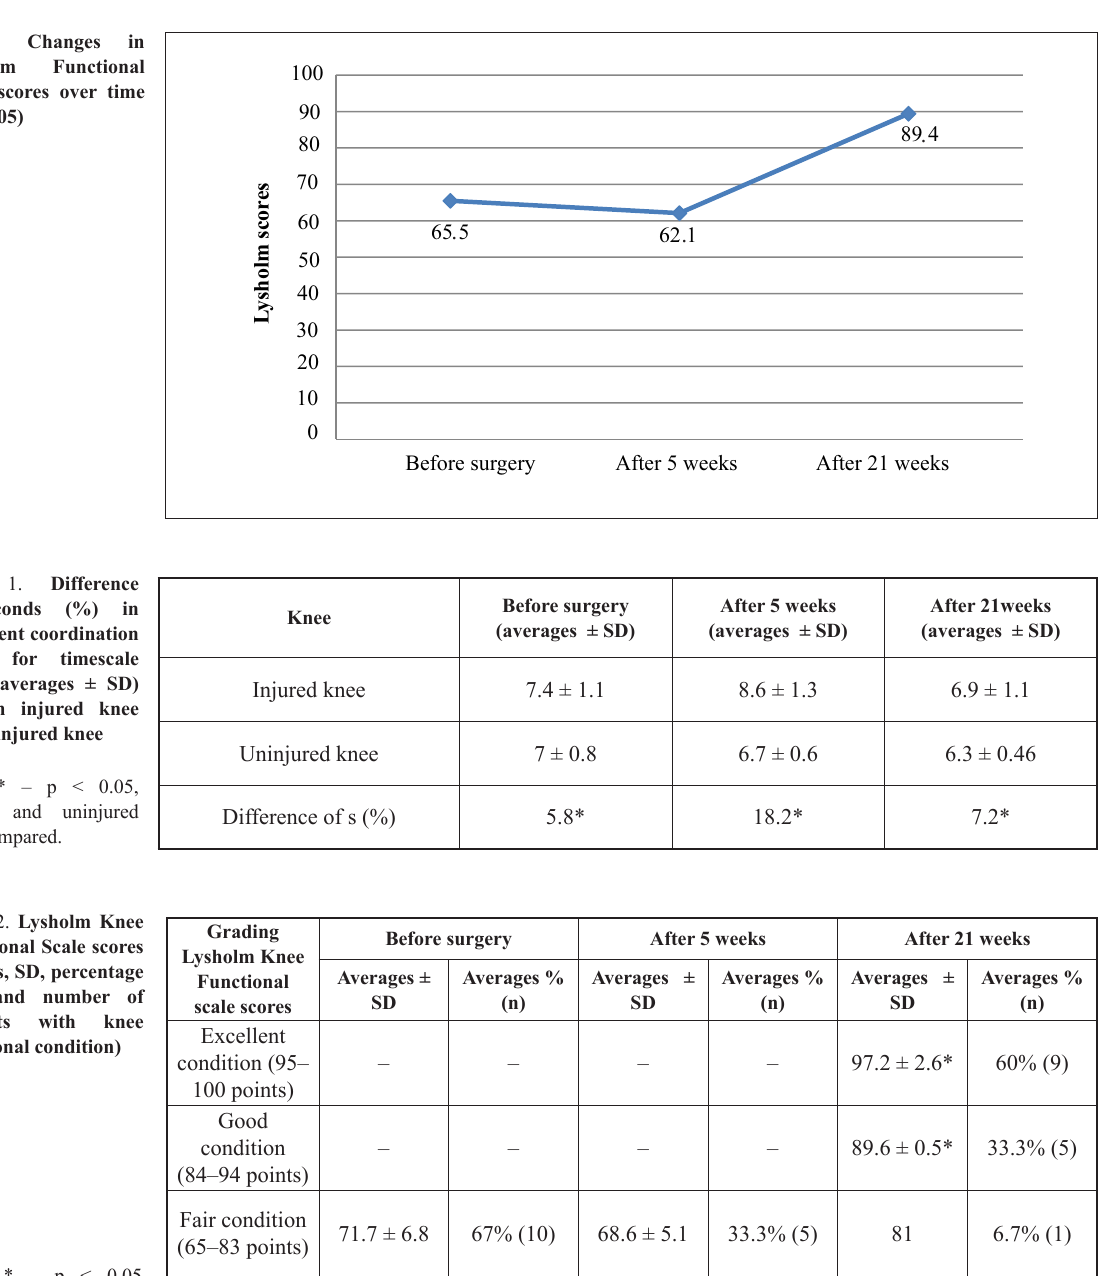
Figure. Changes in Lysholm Functional Scale scores over time